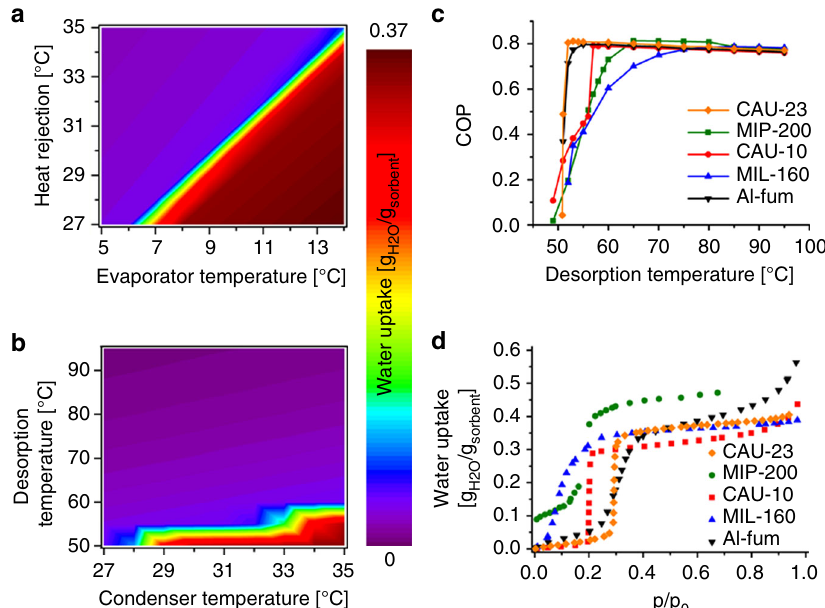
Fig. 5 Calculation of adsorption driven chiller temperature boundaries for CAU-23 and coef fi cient of performance values for cooling in comparison with selected state of the art materials. Calculated loading of CAU-23 for different temperatures used in an ADC setup for adsorption a , and desorption b , cycles. c Calculation of the COP values for different driving temperatures (assumed desired cooling of 10 °C and back cooling temperature of 30 °C). d Water adsorption curves at 40 °C of selected